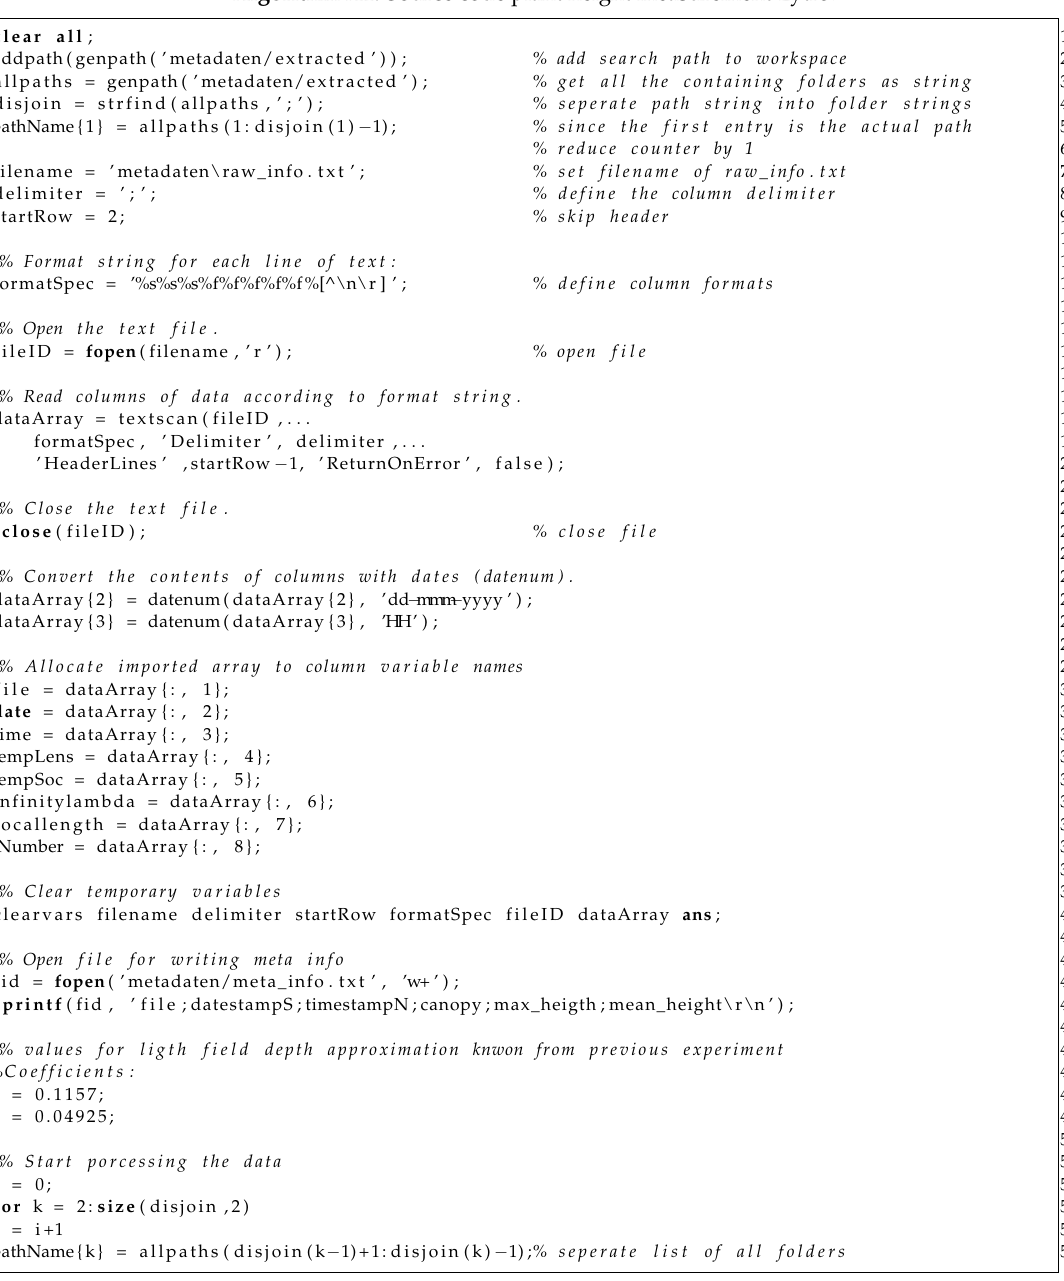
Algorithm A1. Source code plant height measurement